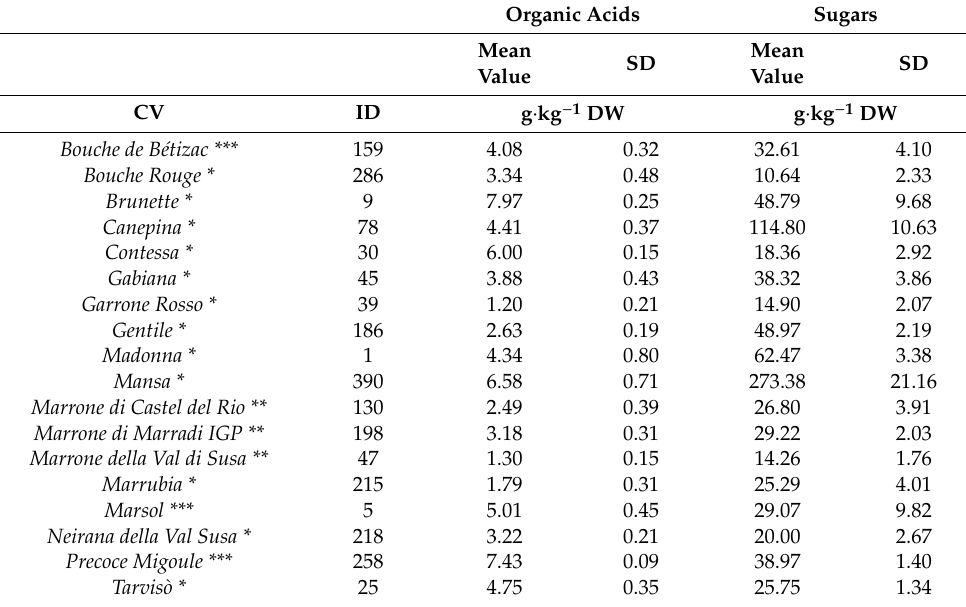
Table 5. Nutritional properties of analysed chestnut cultivars. Organic